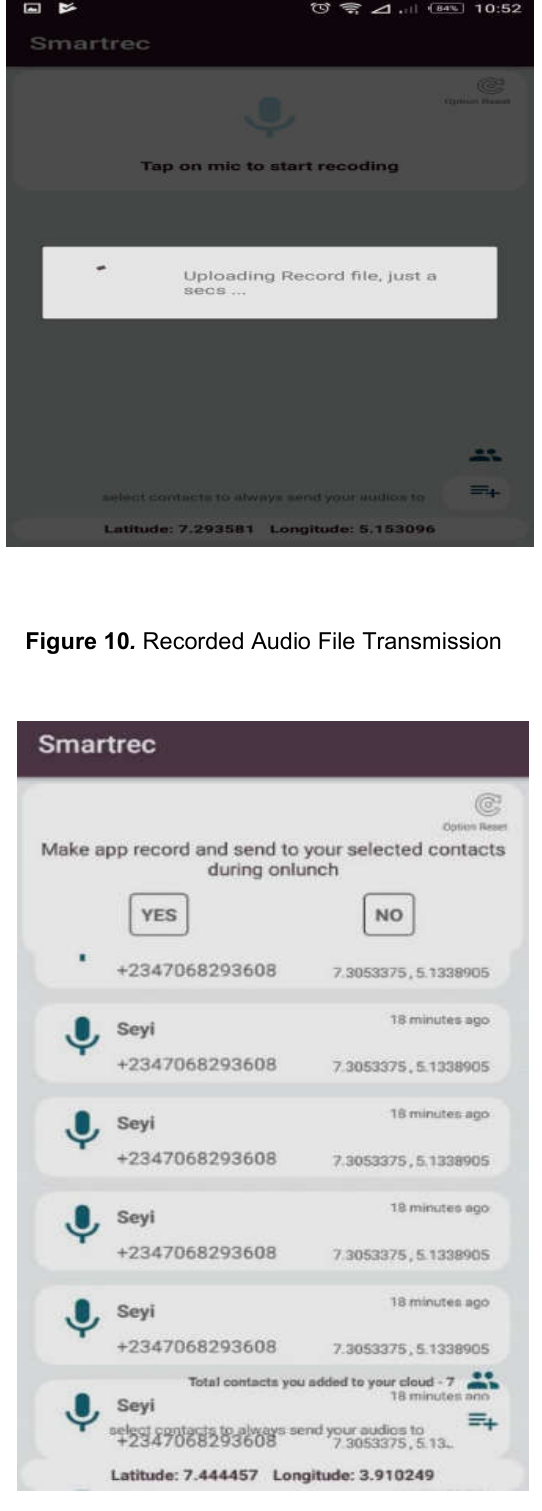
Figure 11 . Received Audio